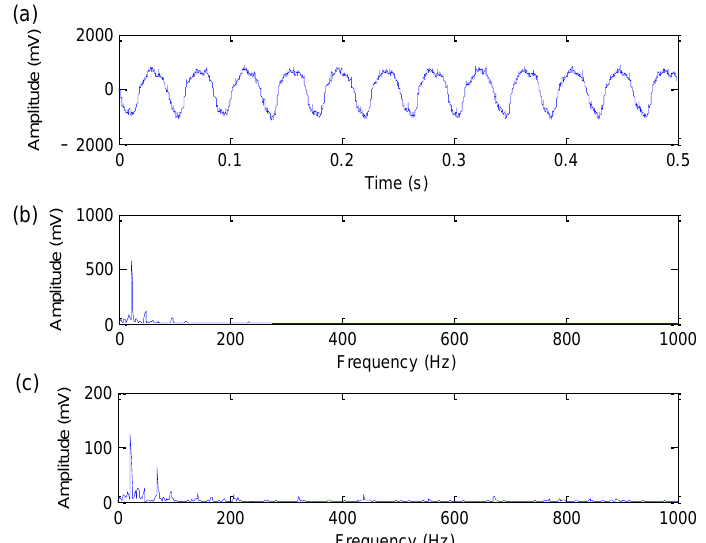
Figure 12. Bearing outer race fault signal: ( a ) Time domain waveform; ( b ) amplitude spectrum; ( c ) envelope spectrum.